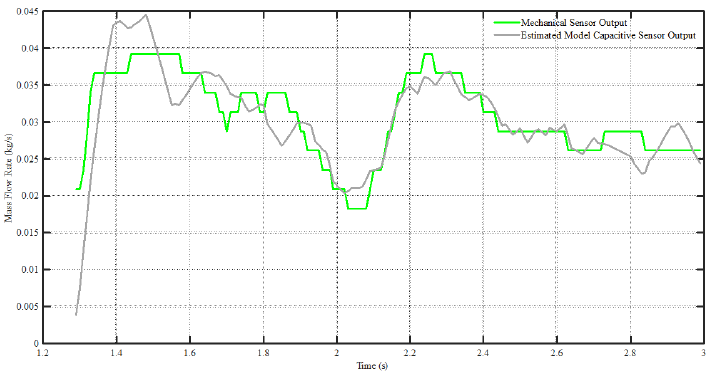
Figure 18. MFR mechanical sensor as a function of MFR capacitive sensor.